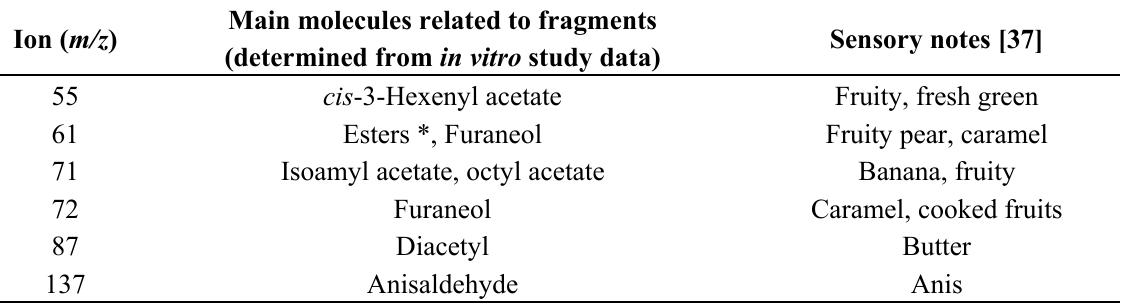
Table 3. Description of the fragments ( m/z ) monitored during in vivo measurements by PTR-MS, the main molecules from which they are derived and the main sensory